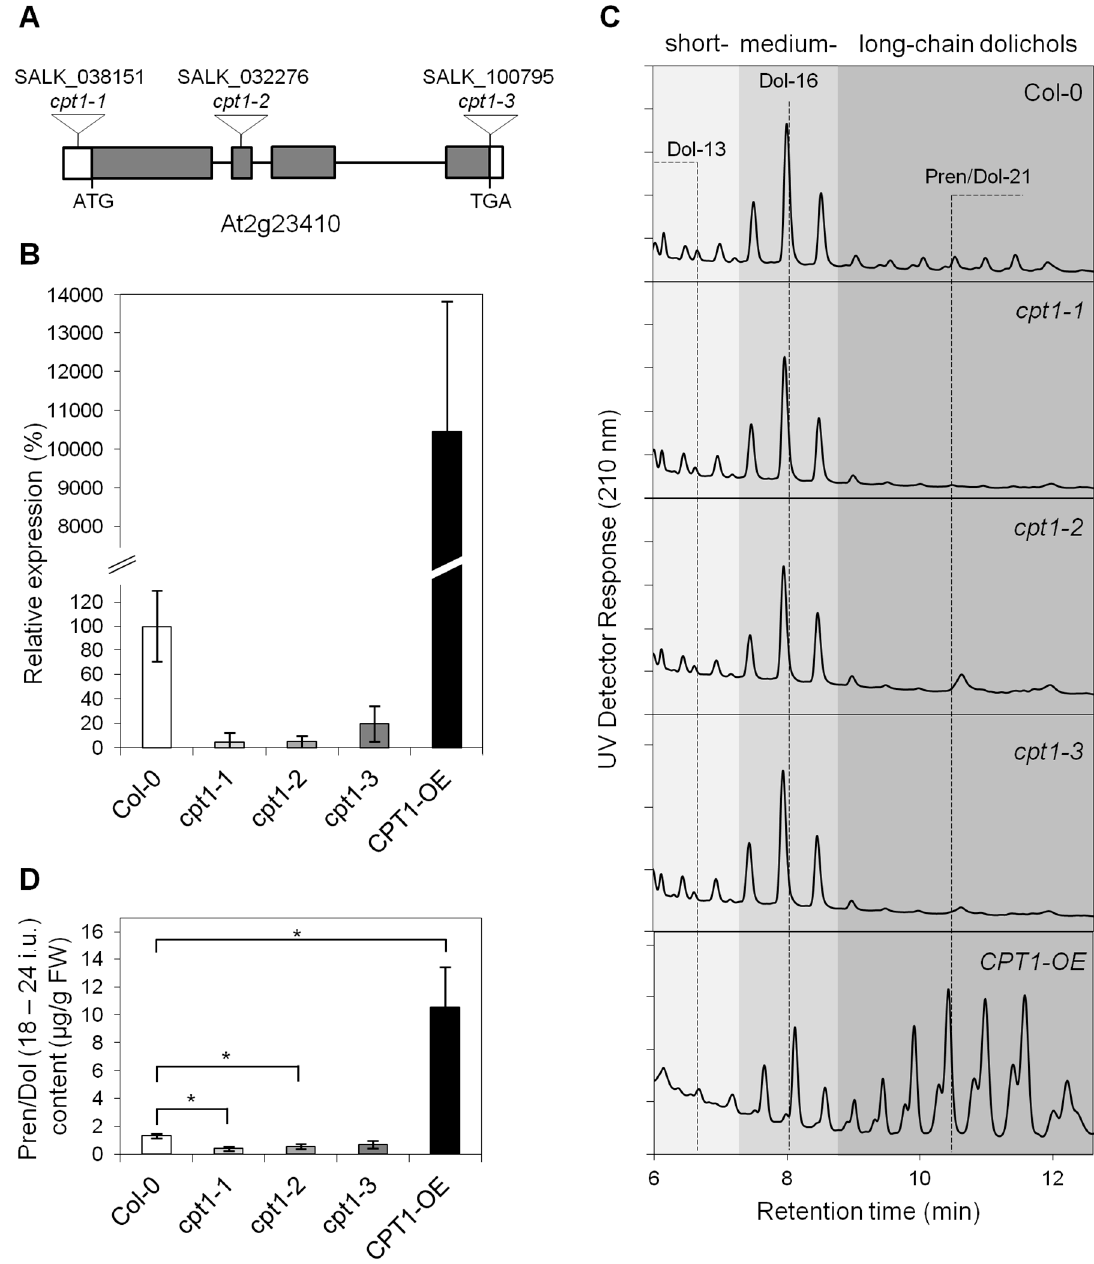
Figure 2. The effect of AtCPT1 deficiency or overexpression on long-chain dolichols accumulation— in planta analysis. ( A ) AtCPT1 gene structure. The start codon (ATG) and the stop codon (TGA) are indicated. Gray boxes indicate exons, and lines between boxes indicate introns. The T-DNA insertion sites in cpt1-1, cpt1-2 and cpt1-3 mutant lines are shown. ( B ) Relative expression of AtCPT1 in Arabidopsis roots of the wild type (Col-0), three independent T-DNA insertion mutant lines ( cpt1-1 , cpt1-2 and cpt1-3 ) and AtCPT1 overexpressing line ( CPT1-OE ). AtCPT1 mRNA abundance was quantified by Real-Time PCR and is presented as a percentage of the wild type (100%). ( C ) Representative HPLC/UV chromatograms of total polyisoprenoids extracted from the roots of Arabidopsis wild typeT-DNA insertion mutants and CPT1-OE plants. The dominating homologues of polyprenols and dolichols accumulated in Arabidopsis roots, Dol-13, Dol-16 and Pren/Dol-21, respectively are indicated. ( D ) Quantification of the long-chain polyprenols and dolichols extracted from roots of studied plants. Data represents three independent experiments. Asterisk (*) indicates significant difference (0.01< P < 0.05 in Student’s t-test) between WT and mutant plants.